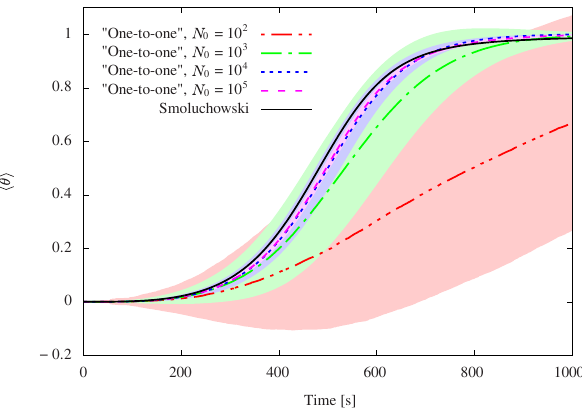
Figure 7. Rain content ratio θ for different cell sizes averaged over ensembles of (cid:127) = 10 3 simulations. Shaded regions show 1 standard deviation interval.